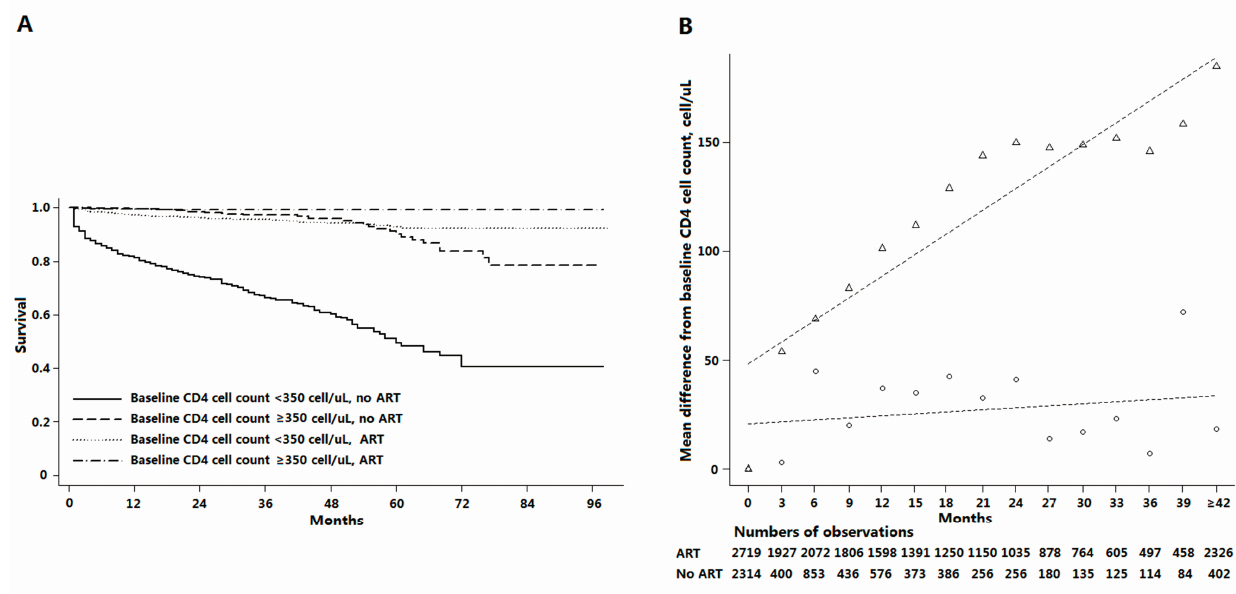
Figure 1. Effectiveness of antiretroviral therapy on survival and changes in CD4 cell counts. ( A ) Kaplan-Meier survival estimates by baseline CD4 cell count and by treatment status. For patients receiving antiretroviral therapy (ART), time is months since commencement of therapy. For patients without ART, time is months since enrollment in this study. ( B ) Changes in CD4 cell counts over time as percentages of baseline CD4 cell counts. For patients receiving ART (triangle), time is months since commencement of